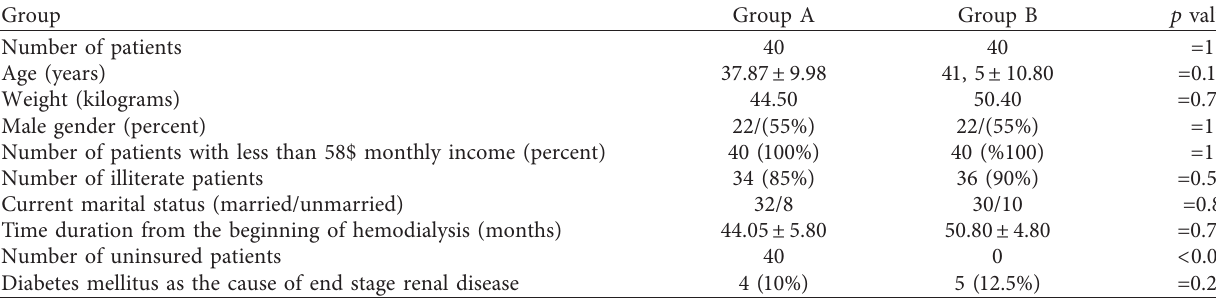
Table 1: Some basic demographic and social and economic characteristics of two groups that were matched from the beginning of the study.